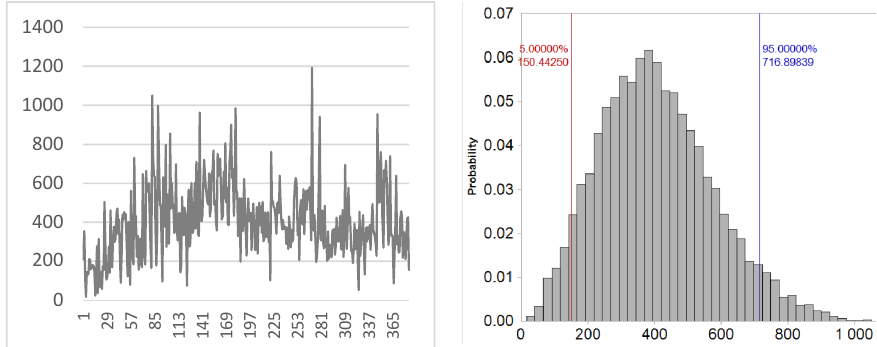
Figure 6. Distribution of economic effects (profits) for energy storage in the shaft. On the left: X axis—consecutive daily observations, Y axis—economic effect, on the right: X axis—economic effect, Y axis—probability. Source: own report.